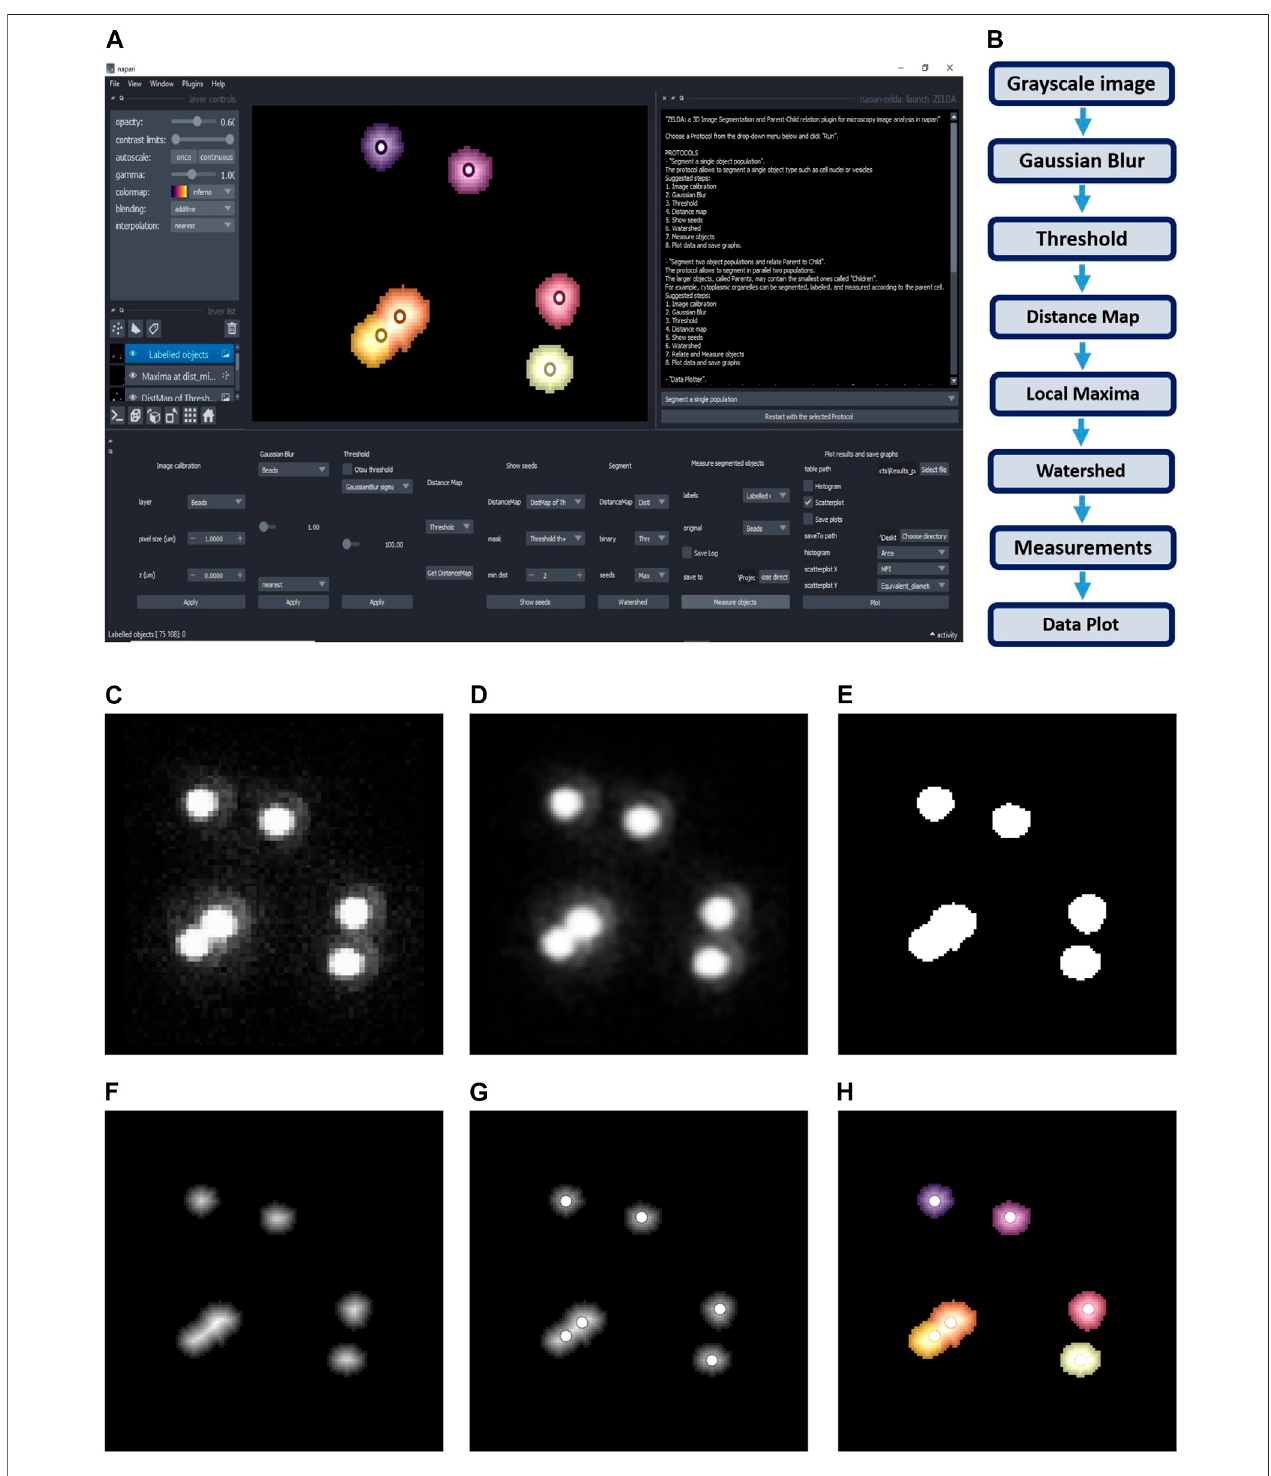
FIGURE 1 | ZELDA plugin for napari . (A) GUI of ZELDA with the description of the ready-to-use protocols suf fi cient to run a complete image analysis work fl ow (white text box on the top right). Each protocol is divided into numbered steps corresponding to the software commands in the napari dock widget (bottom of the software interface). (B) “ Segment a single population ” protocol including a minimum number of processing operations. (C) Original image. (D) Gaussian Blur of the originalimage. (E) BinaryimageobtainedapplyingaThresholdtothegaussianblur. (F) DistanceMapappliedtothebinaryimage. (G) Seeds(LocalMaxima)usedto run the Watershed. (H) Objects labelled by Watershed. The labelled objects can then be measured, and the results exported.